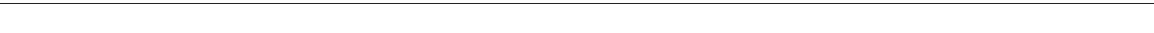
Fig. 4 Inhibition of NOX4 sensitizes RCC cells to drug-induced cell death. a shVector or shNOX4 786-O stable cell lines were incubated (+) or not ( − )